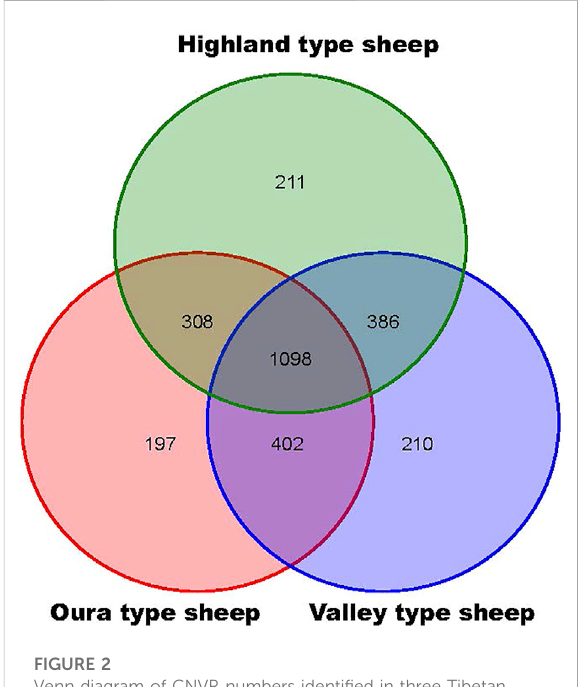
FIGURE 2 Venn diagram of CNVR numbers identi fi ed in three Tibetan sheep